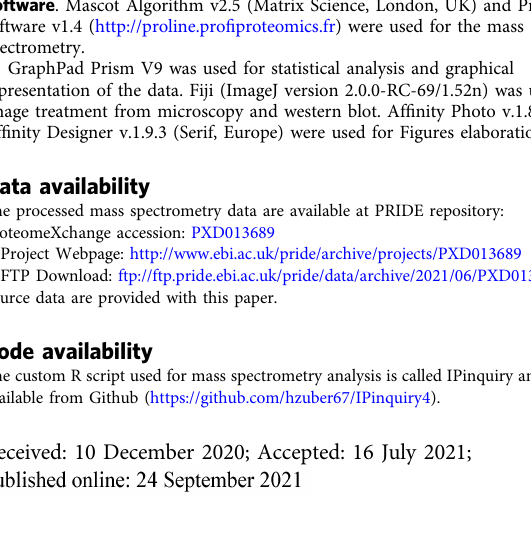
are indicated in the corresponding Figure and Figure legends. Experiment repli- cations are summarized in Table S1. Software . Mascot Algorithm v2.5 (Matrix Science, London, UK) and Proline software v1.4 (http://proline.pro fi proteomics.fr) were used for the mass spectrometry. GraphPad Prism V9 was used for statistical analysis and graphical representation of the data. Fiji (ImageJ version 2.0.0-RC-69/1.52n) was used for Image treatment from microscopy and western blot. Af fi nity Photo v.1.8.5 and Af fi nity Designer v.1.9.3 (Serif, Europe) were used for Figures